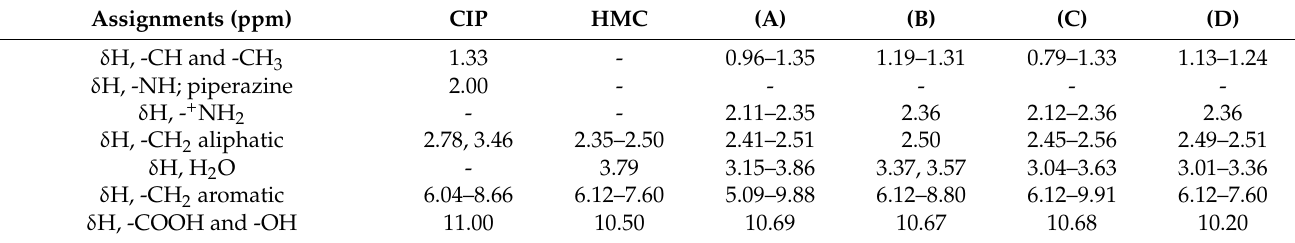
Table 4. 1 H NMR values (ppm) and tentative assignments for CIP, HMC, and their Zr(IV)